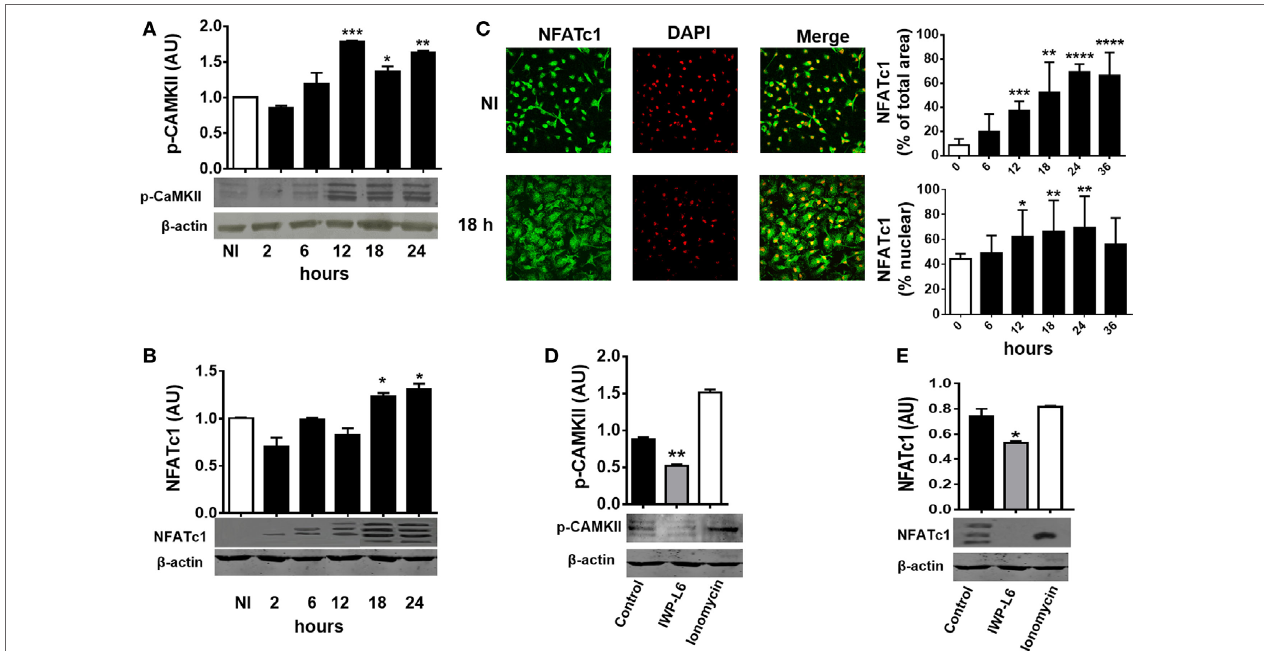
FigUre 4 | Trypanosoma cruzi infection induces late Wnt/Ca + 2 pathway activation in macrophages. Bone marrow-derived macrophages were in vitro infected with trypomastigotes (Tps) of T. cruzi or left uninfected (NI) and then evaluated for calcium/calmodulin-dependent kinase II (CaMKII) phosphorylated at Thr286 expression and NFATc1 expression and localization at different times post-infection (pi). Phosphorylated CAMKII (p-CAMKII) expression (a) and NFATc1 expression (B) were assessed by Western blot and normalized to β -actin. (c) Expression and localization of β -catenin by immunofluorescence and confocal microscopy. A representative field for each group is shown (1,200 × ). Nuclear staining was detected with 4 ′ ,6-diamidino-2-phenylindone (DAPI), and the levels of expression of NFATc1 (% of total area) and the threshold Mander’s colocalization (% nuclear) coefficients calculated using FIJI/ImageJ program as described in Section “Materials and Methods.” Green, NFATc1; red, DAPI. (D,e) Bone marrow-derived macrophages (BMM) were treated for 24 h with the PORCN inhibitor (IWP-L6) or left untreated (control), infected with T. cruzi Tps and assayed for p-CaMKII and NFATc1 expression at 24 h pi. Ionomycin-activated BMM (20 min, 1 µM) were used as a positive control. In panels (a,B,D,e) , a representative Western blot and the ratio of protein expression to β -actin are shown. The results are expressed as the average of three independent experiments ± SEM. Abbreviation: AU, arbitrary units (* P < 0.05; ** P < 0.01; *** P < 0.001; and **** P <